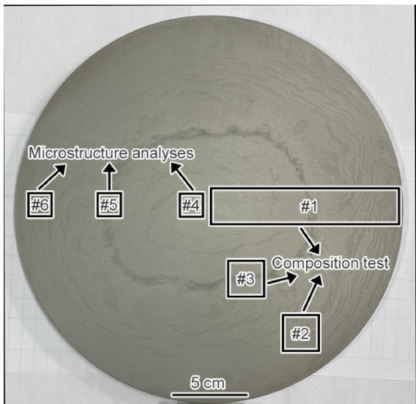
Figure 3. The macrostructure of the experimental steel and the schematic diagram of